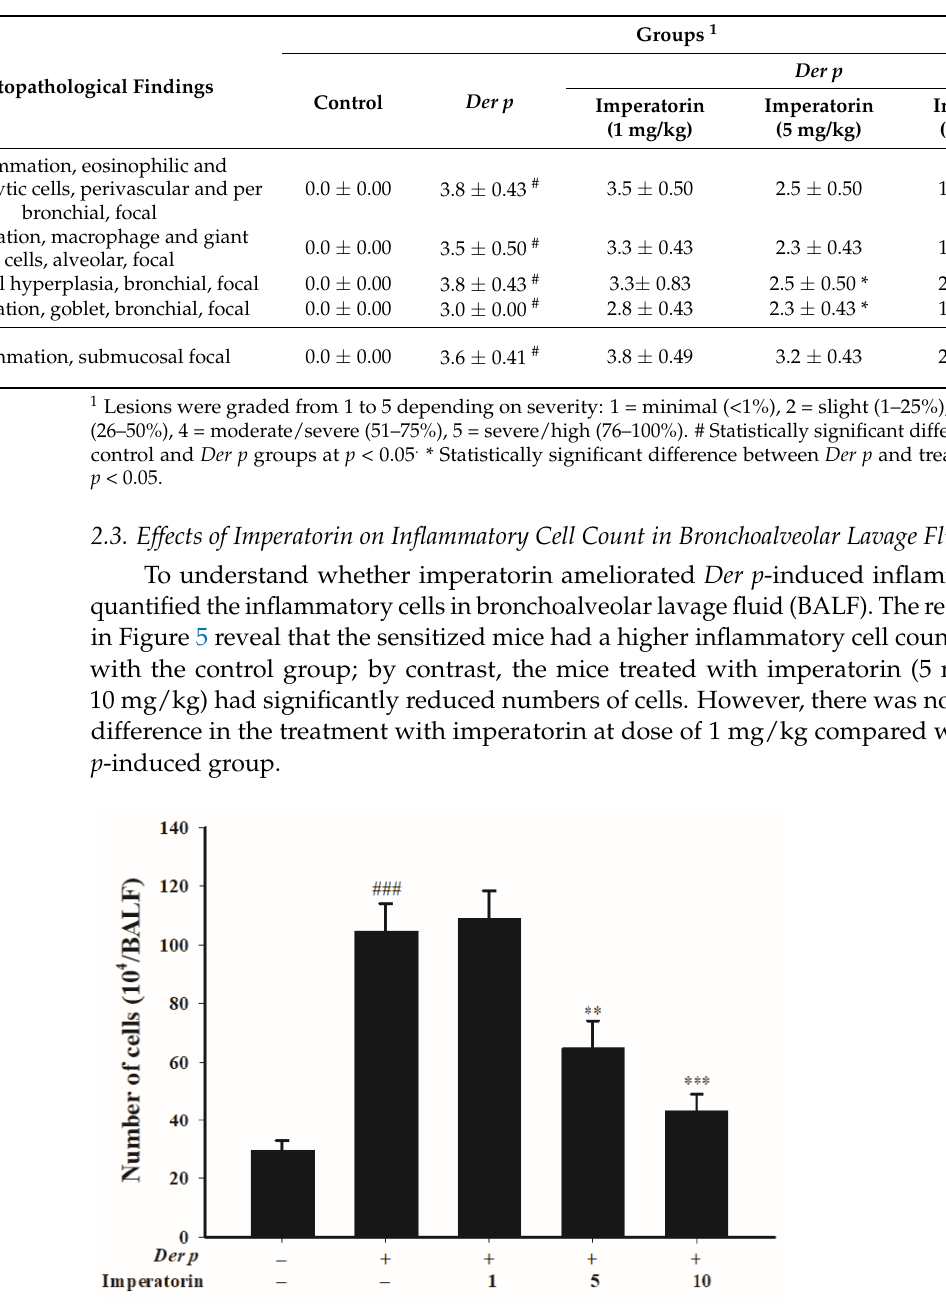
Table 1. Quantitative summary of the protective effect of imperatorin on Der p -induced allergic asthma based on histological observations.